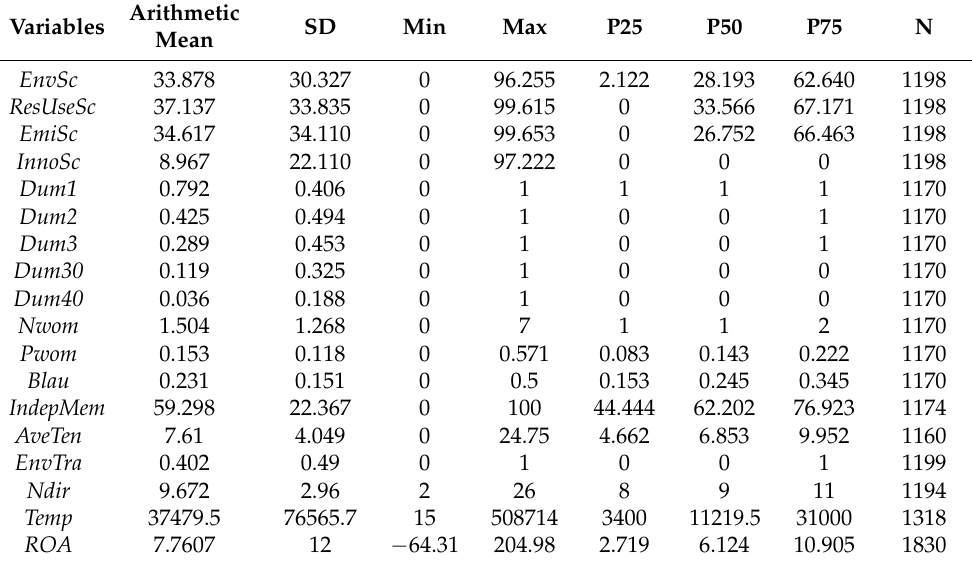
Table 6. Descriptive statistics of the variables